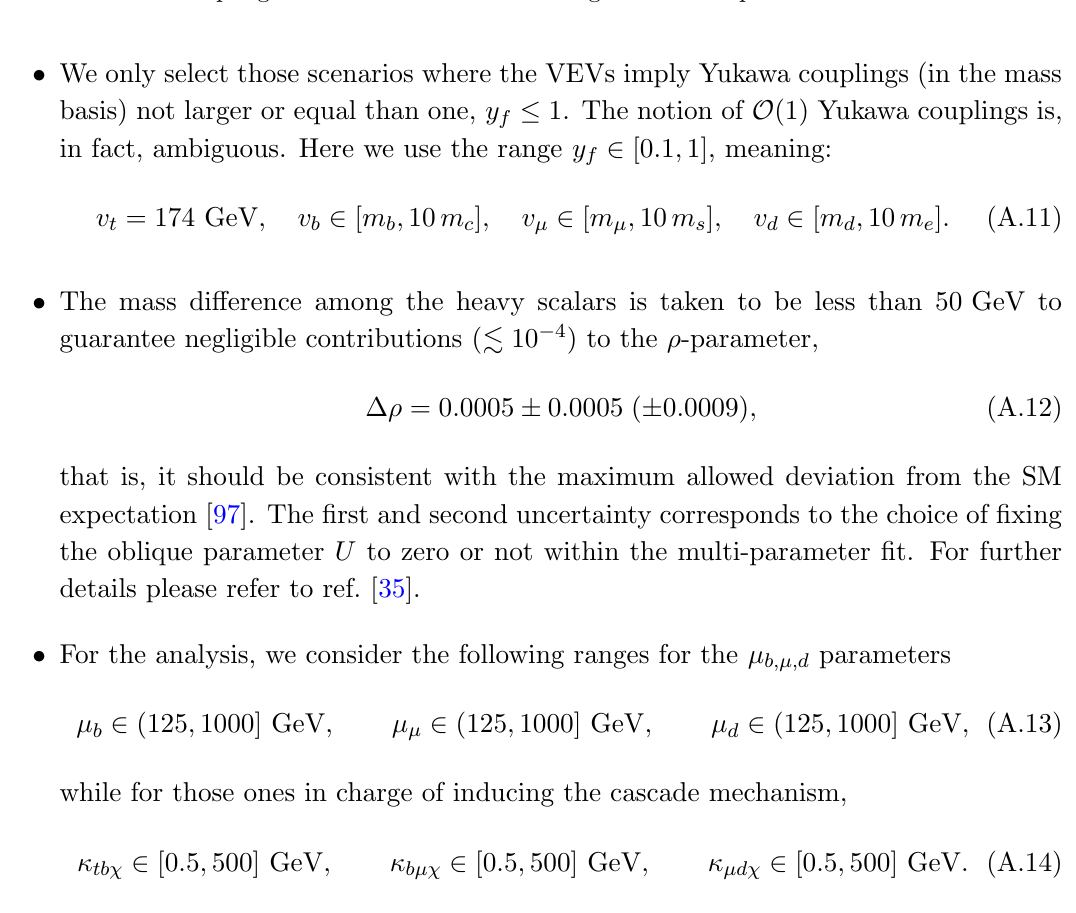
A 0 . The chaotic k ! k